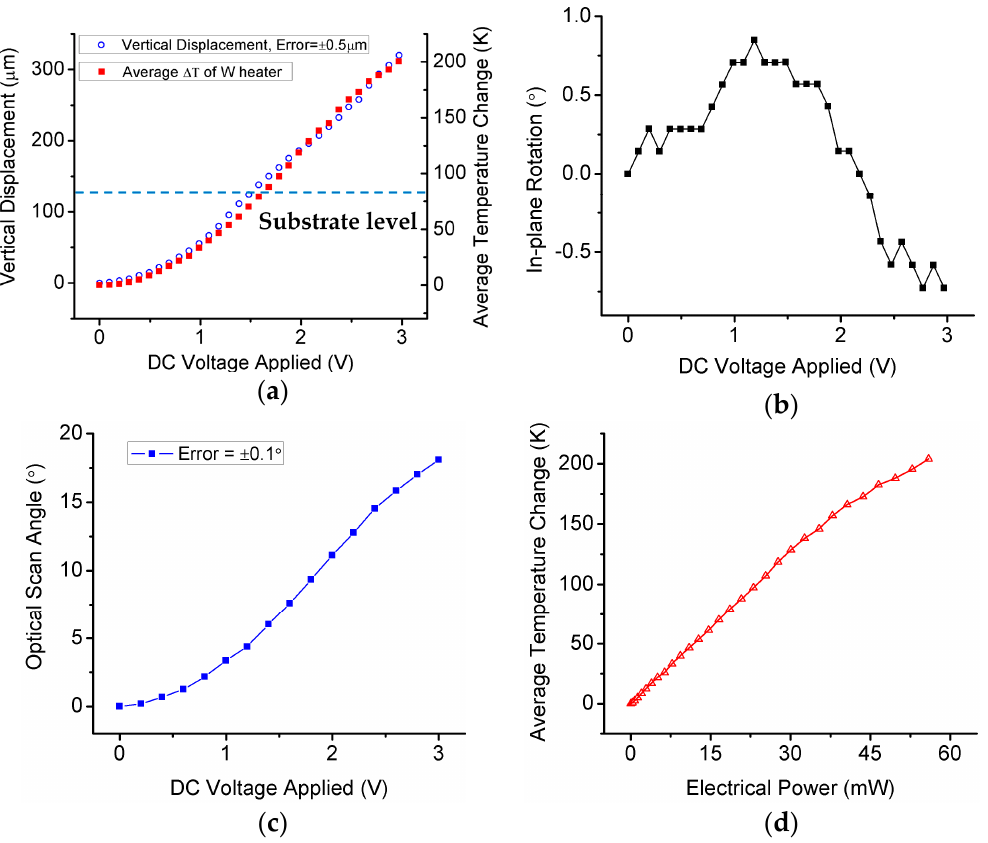
Figure 8. Static responses of the fabricated MEMS mirror. ( a ) Vertical displacement and average temperature change versus applied DC voltage; ( b ) In-plane rotation of the mirror plate versus applied DC voltage; ( c ) Optical scan angle versus applied DC voltage by actuating one actuator; ( d ) Average temperature change versus input electrical power.